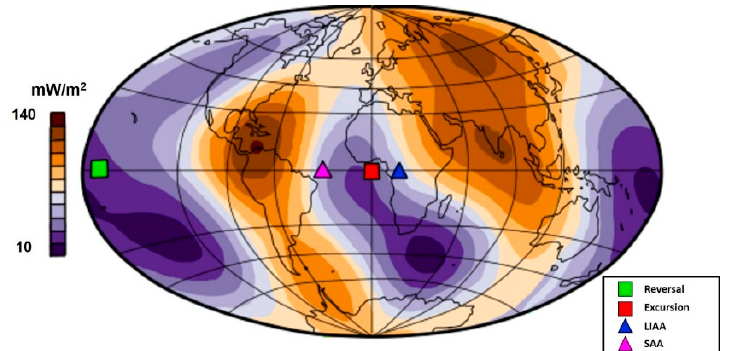
Figure 7. Present-day CMB heat flux from a mantle Global Circulation Model. Icons indicate the longitude of the first dipole reversed (increased for LIAA) according to the 360-DRM for each event studied (see legend). Adapted from Olson [61].